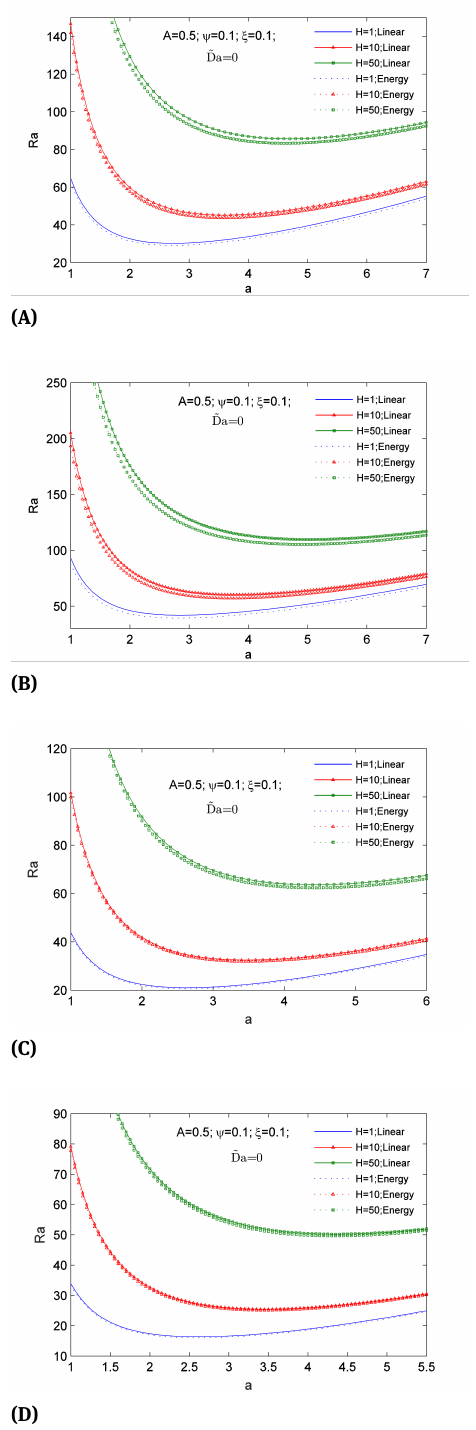
Fig. 4: Neutral stability curves for case A, B, C and D at different values of ξ and fixed values of H , ψ , ˜ Da , A